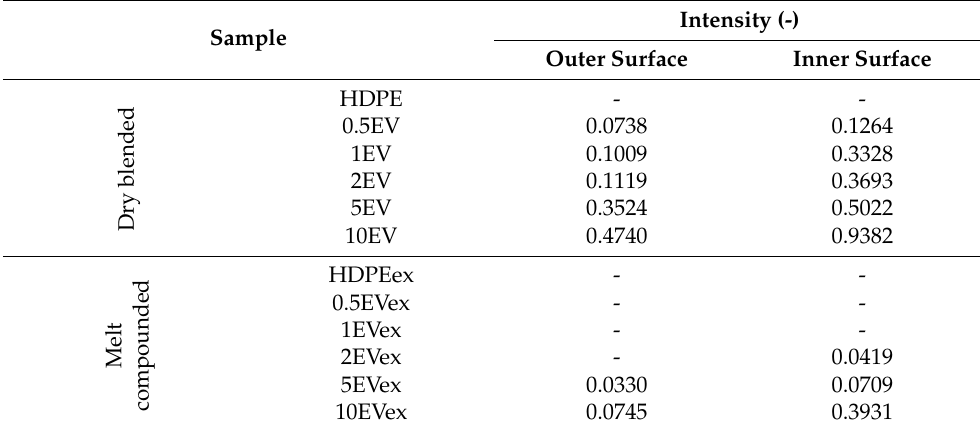
Table 1. The intensity of the FTIR absorption peak related to the Si–O bond.